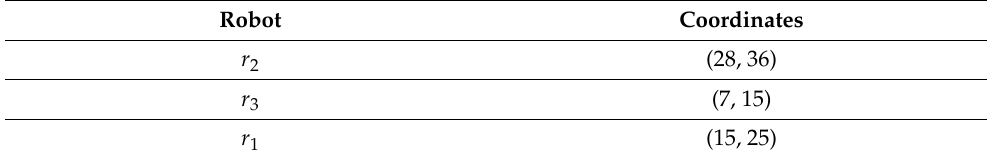
Table 5. Coordinates of robots waiting to be towed.